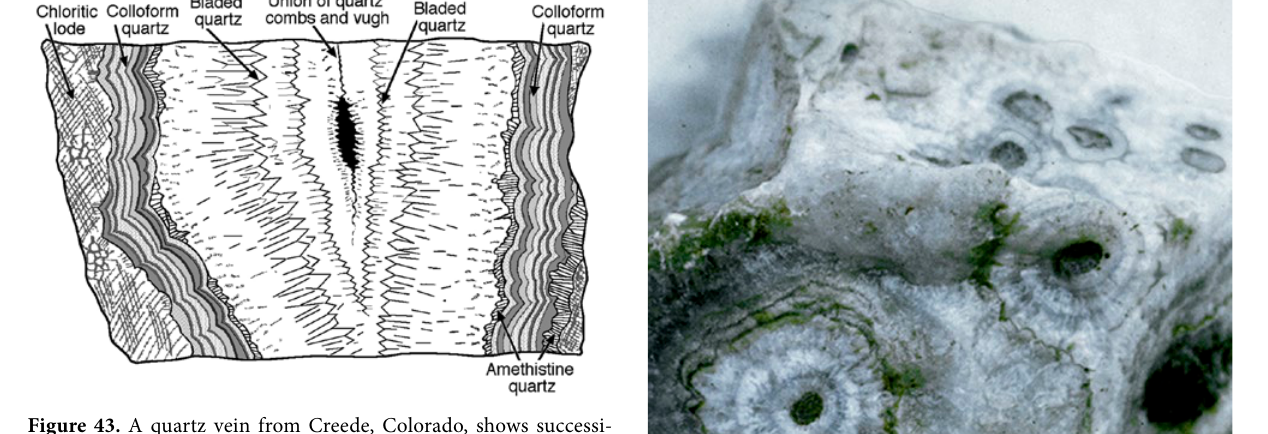
Figure 43. A quartz vein from Creede, Colorado, shows successi- ve crystallisation of bladed quartz towards a central vug from col- loform banded quartz deposited near the vein walls. The history of aging of the polymeric silica in this vein is plainly the same as that in geodes where a similar pattern (Figure 26 on page 56) of cleaner crystals develops. These grow from colloform outer lay- ers toward a central shrinkage cavity. The chain of shrinkage vugs where it occurs in quartz veins, is usually central along the length of the vein but a pattern of crystallisation from colloform banding confirms the initial introduction of polymeric silica gel.